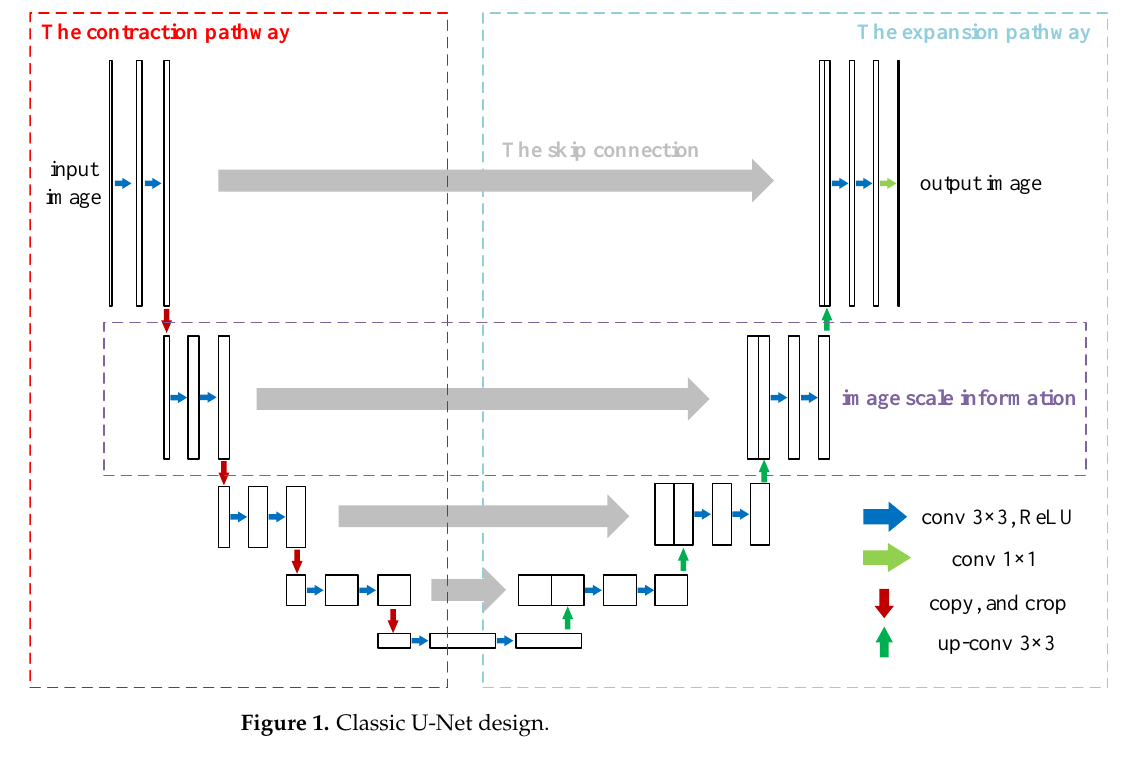
Figure 1. Classic U-Net design.